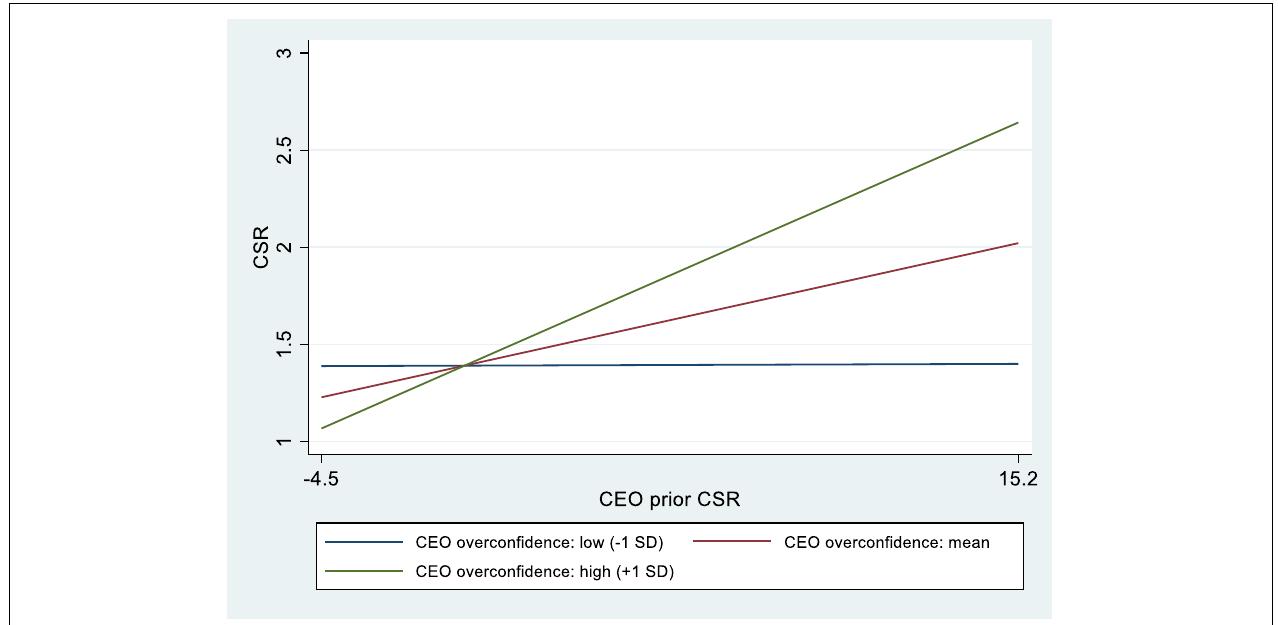
FIGURE 1 | Moderating role of chief executive officer (CEO) overconfidence in the firm CSR-CEO Prior Corporate Social Responsibility (CSR)